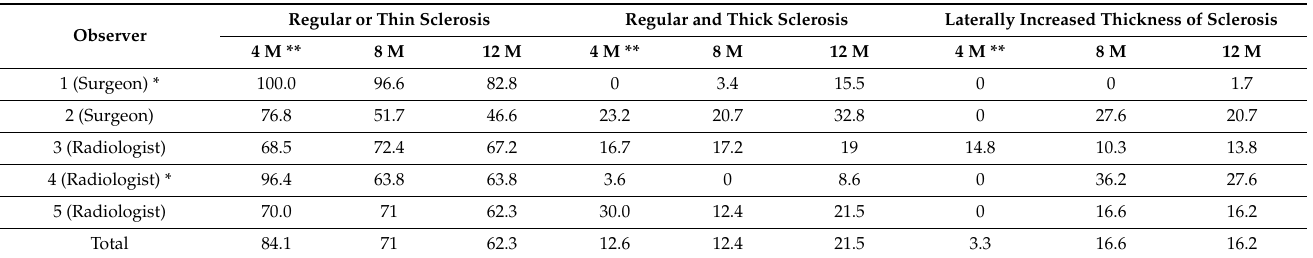
Table 3. Percentages (%) of sclerosis of cranial acetabular rim (SCAR) evaluations by observers at 4 [29], 8, and 12 months of age.